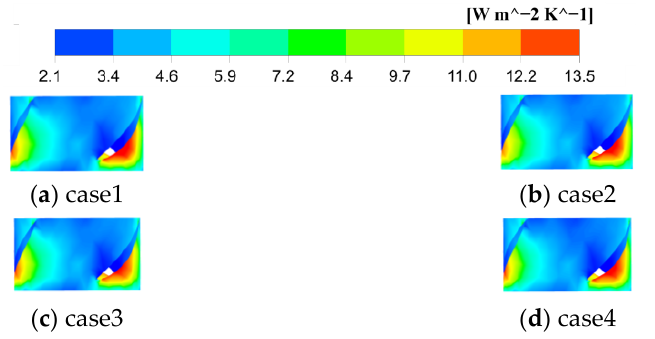
Figure 12. Entropy production contour at the hub.